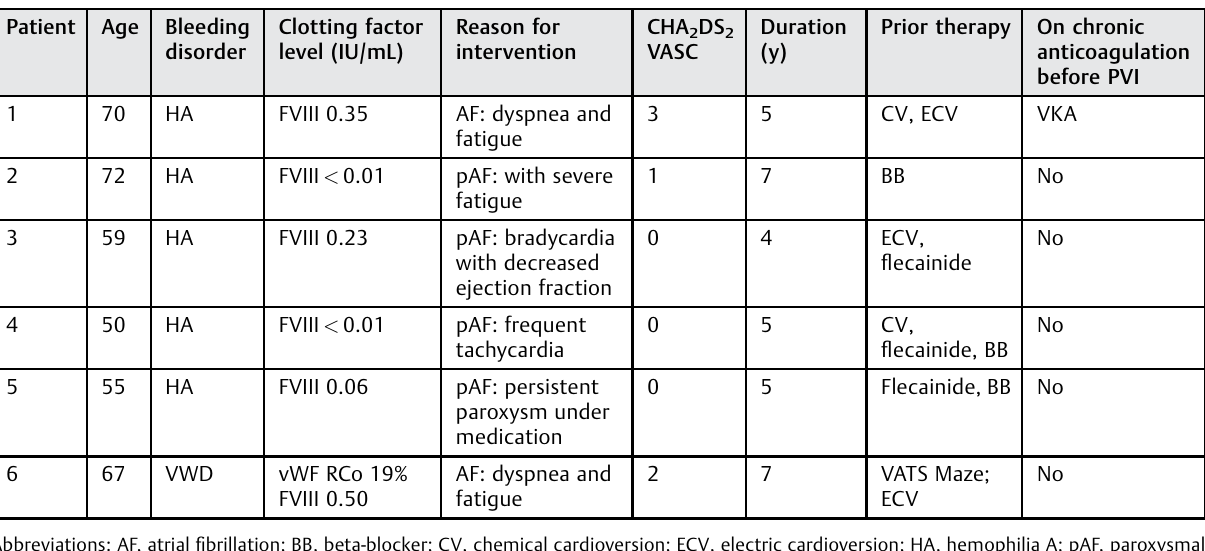
Table 1 Patient